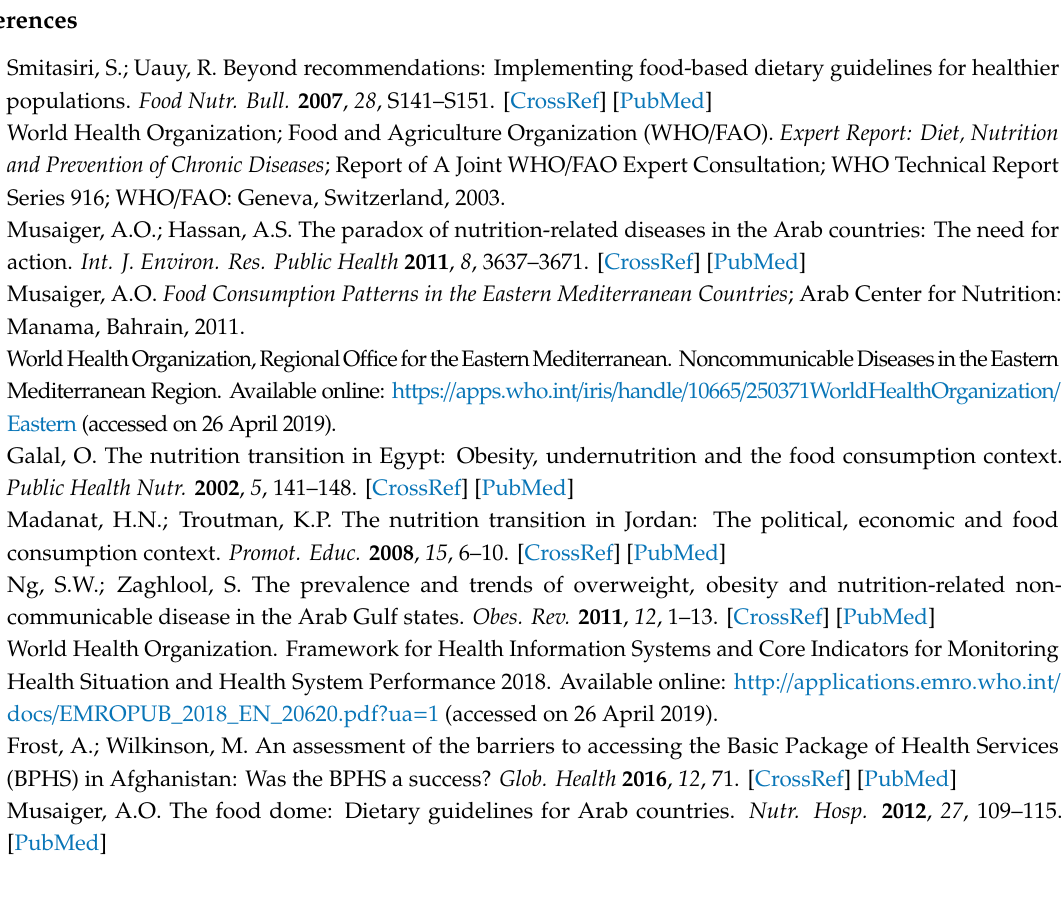
Table S1: Food-Based Dietary Guidelines sources for EMR